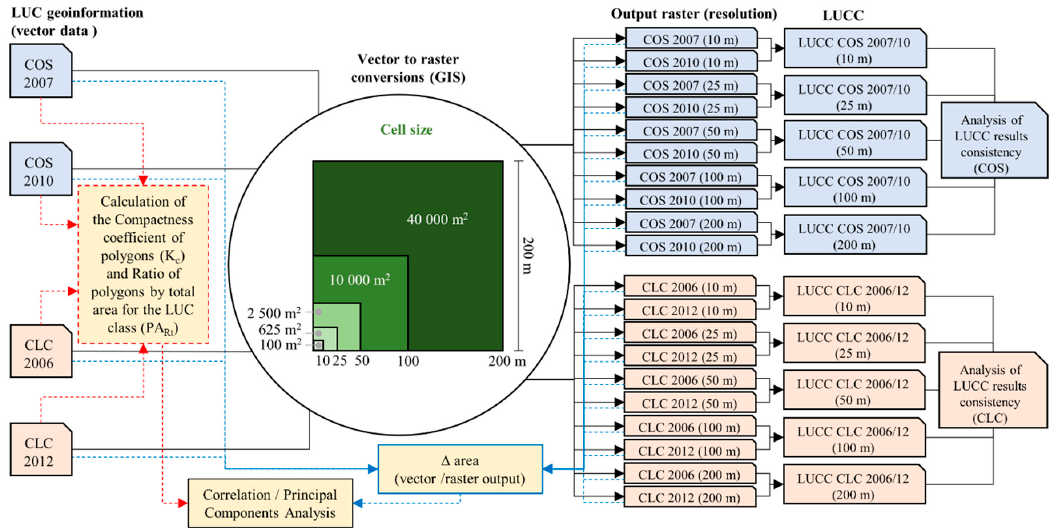
Figure 3. Methodological scheme: LUC GI conversion, LUC outputs, and LUCC.